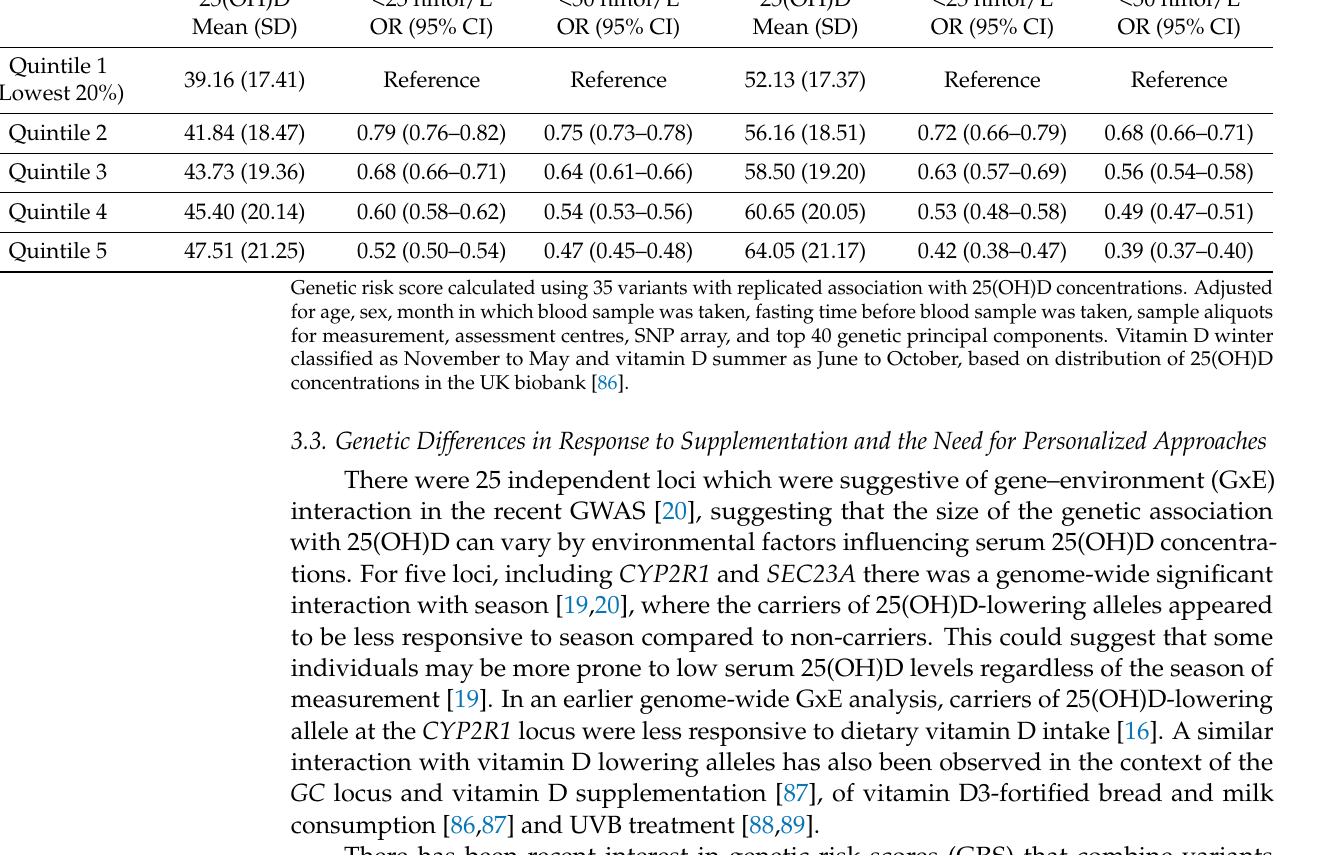
Table 2. Average 25-hydroxyvitamin D level and the odds of low concentrations by quintiles in vitamin D genetic risk score in the UK Biobank.